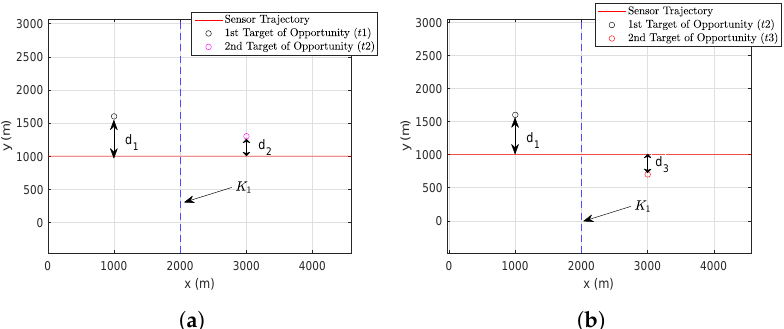
Figure 8. Sensor trajectory formed by the CV model to estimate bias using two known targets of opportunity with additional terrain uncertainty. ( a ) Second target of opportunity ( t 2 ) located d 2 m away from sensor trajectory. ( b ) Second target of opportunity ( t 3 ) located d 3 m away the sensor